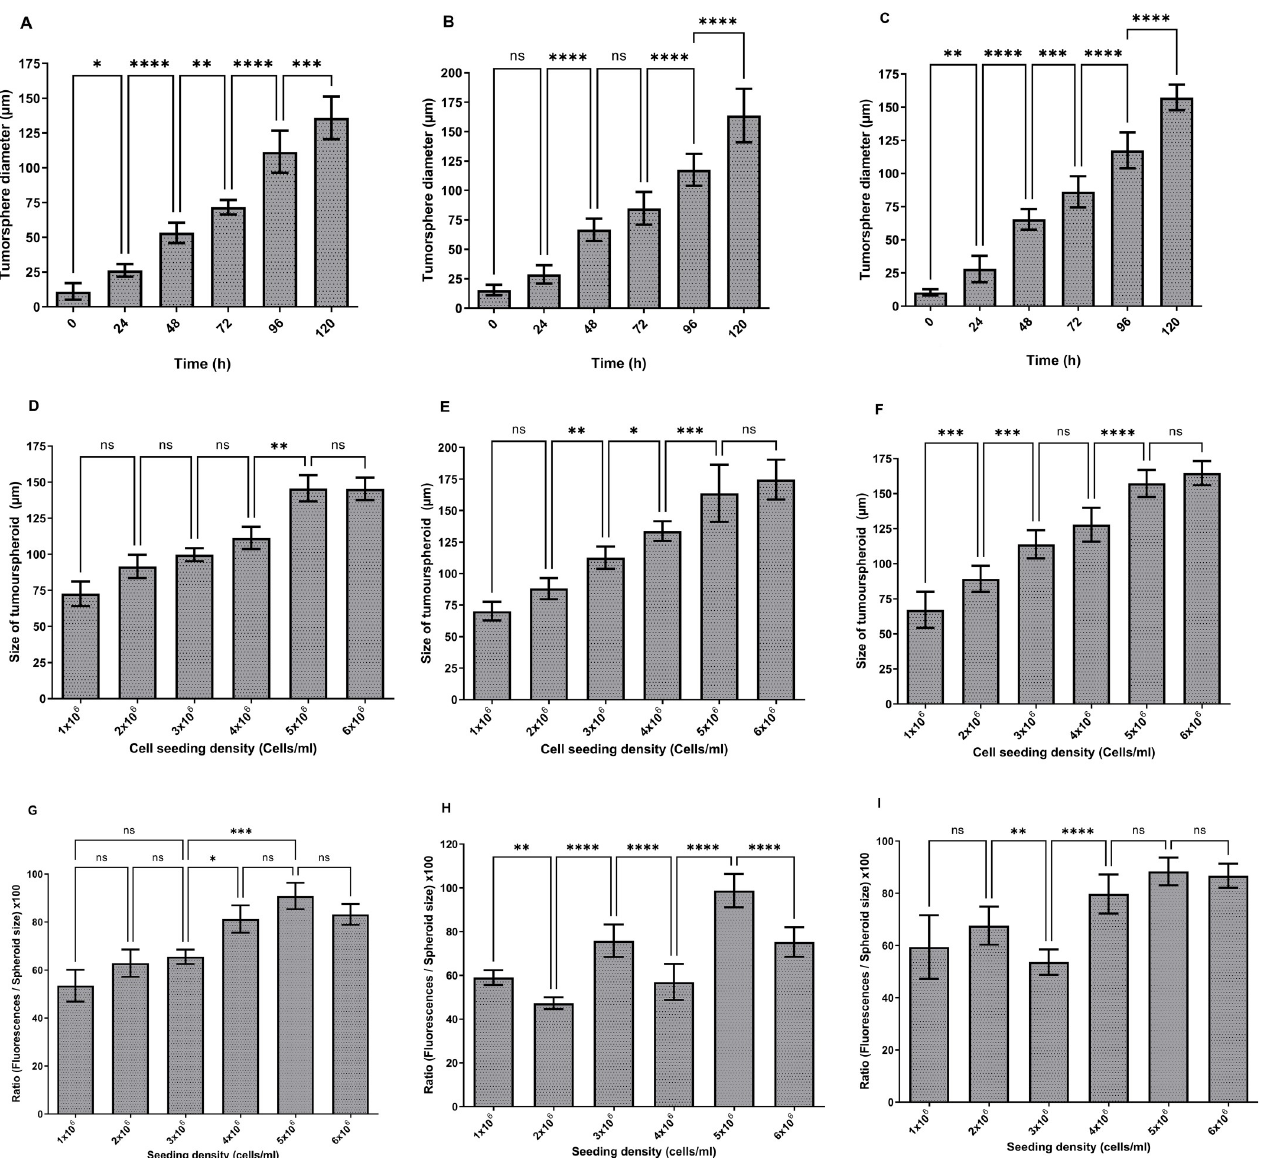
Fig 5. Development of U-251 MG human glioblastoma astrocytoma 3D in vitro cell culture model using cellusponge 3D scaffolds. A) U-251 MG, B) U-87 MG, C) A-172 tumourspheres growth (diameter in μ m) analysis during different incubations. D) U-251 MG E) U-87 MG, F) A-172 Growth analysis after 120 h incubation (diameter in μ m) at increasing seeding density. The mean of the diameter was used to plot the values on columns and analysed using one-way ANOVA with tukey’s post-test (ns, not significant (p > 0.05); � p < 0.05; �� p < 0.01, ��� p < 0.001; ���� p < 0.0001). G) U-251 MG H) U-87 MG, I) A-172 spheroid cell health analysed and a higher ratio indicates healthier spheroids. The mean of the [(fluorescence / spheroid size) x 100] was used to plot the values on columns and analysed using one-way ANOVA with tukey’s post-test (ns, not significant (p > 0.05); � p < 0.05; �� p < 0.01, ��� p < 0.001; ���� p < 0.0001).